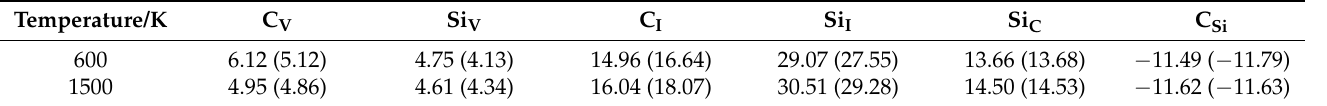
Table 1. Excess volume of various point defects at 600 K and 1500 K ( ν i in Å 3 ). The values